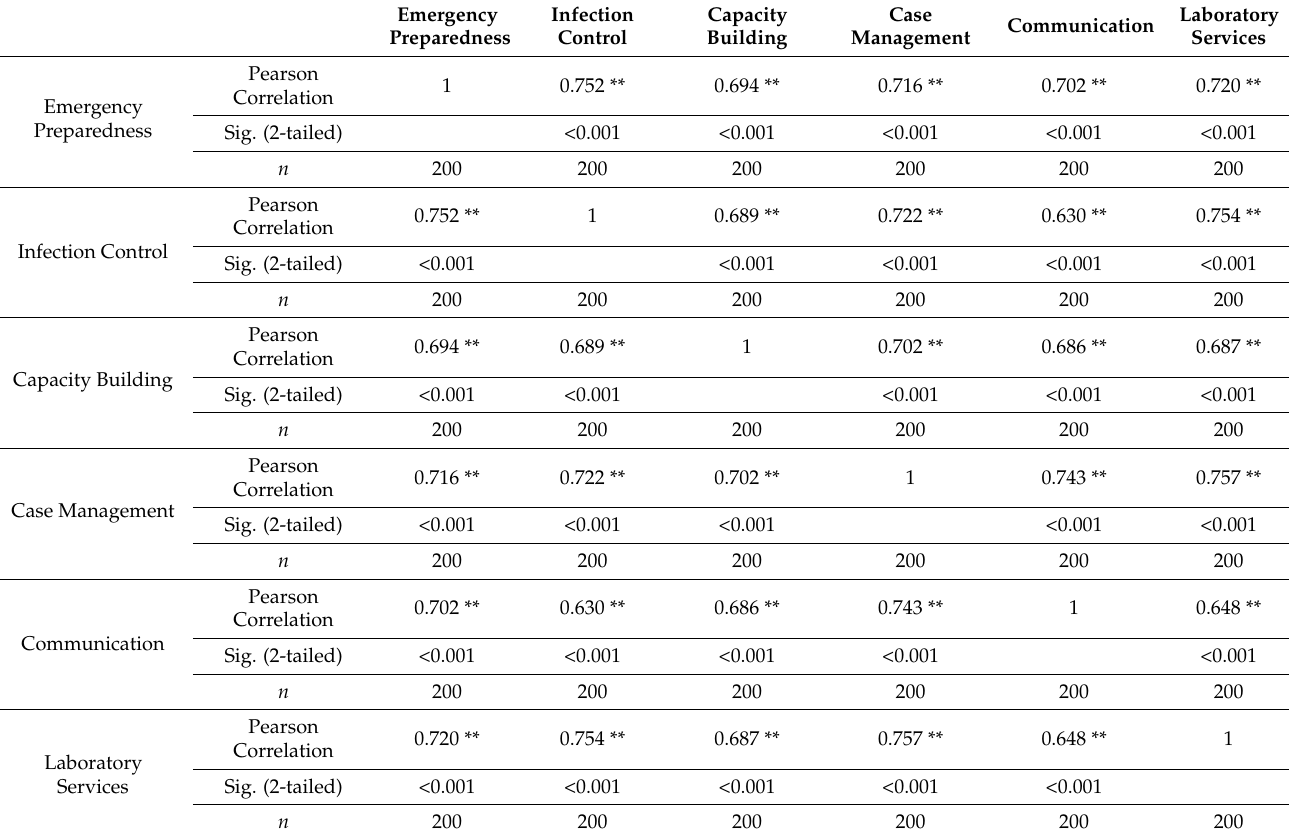
Table 5. Correlation analysis for participants’ responses according to patient safety focus